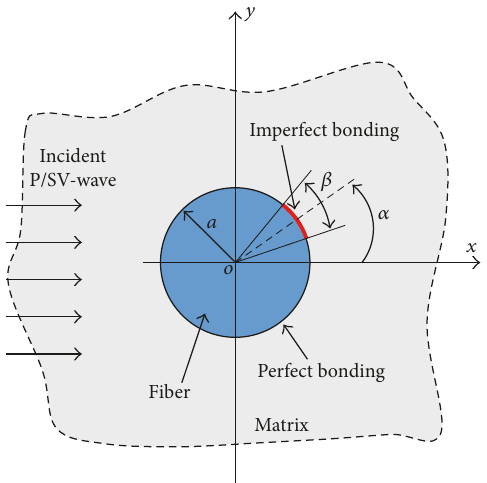
Figure 1: Scattering of a plane P- or SV-wave by a cylindrical fiber with a partially imperfect bonding to the matrix. The range of the imperfect bonding is denoted by the red solid